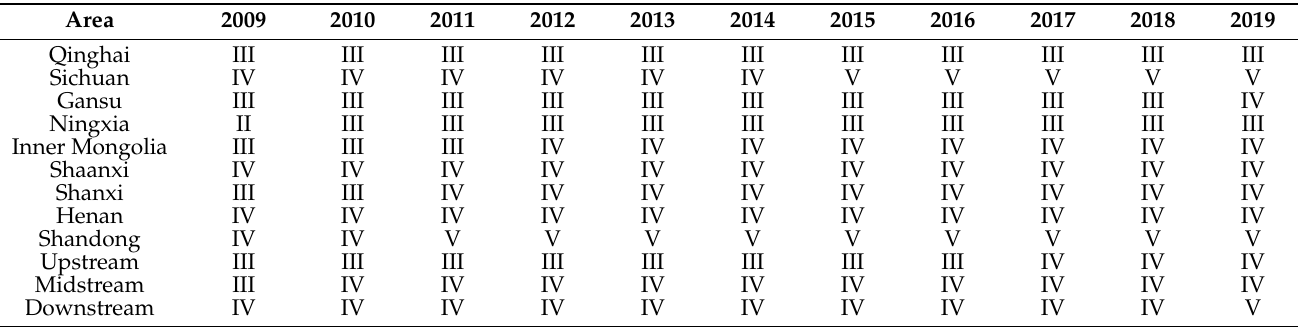
Table 6. Coordinated development levels of provinces and upstream, midstream, and downstream of the Yellow River Basin from 2009 to